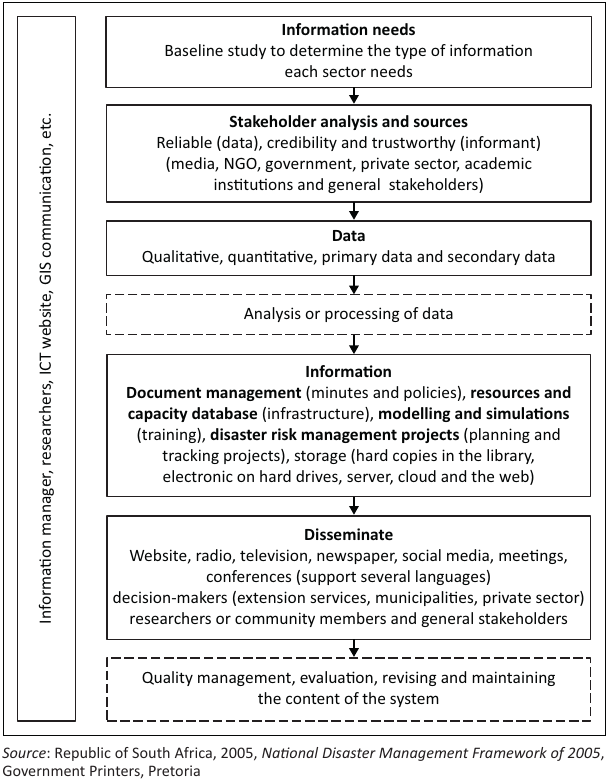
FIGURE 2: Disaster information management and communication system model.